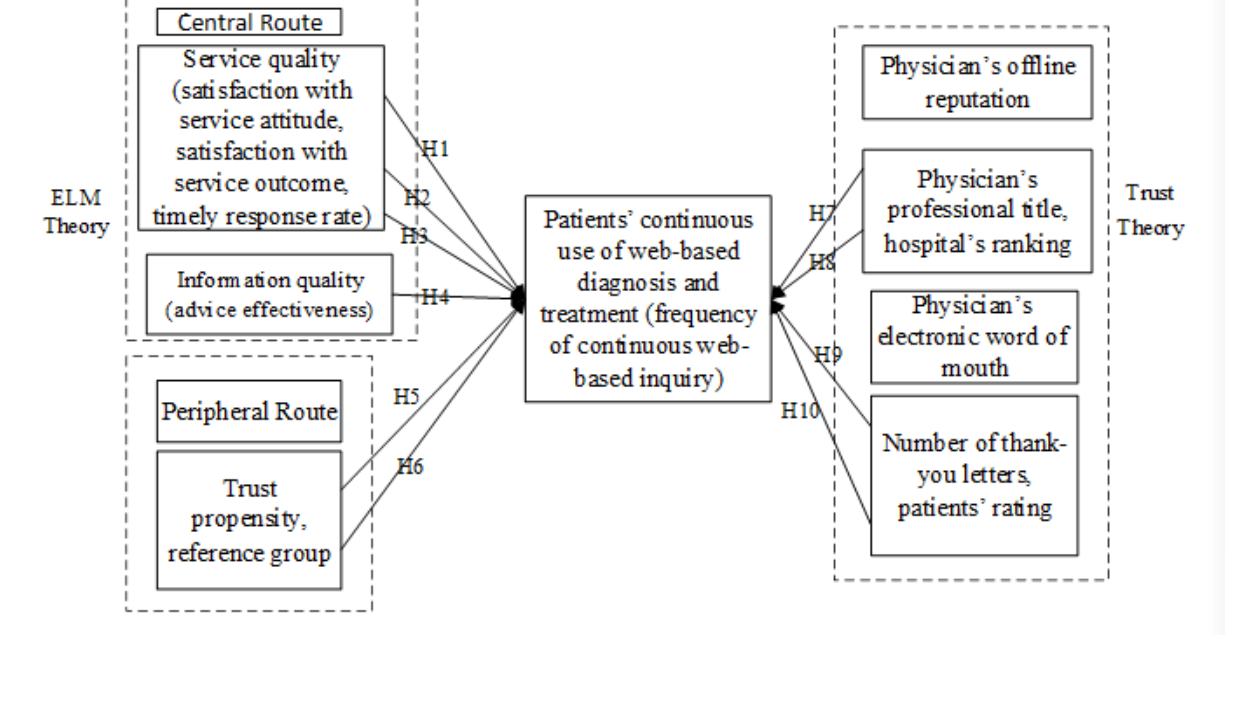
Figure 1. Influencing factor model of behavior toward continuous web-based diagnosis and treatment for patients with diabetes. ELM: elaboration likelihood